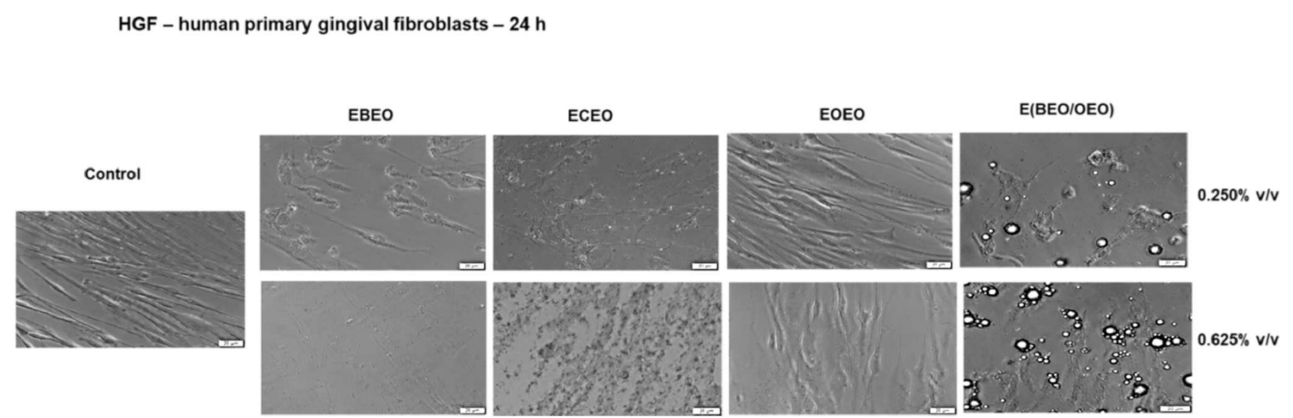
Figure 4. The morphological aspect of HGF in culture: Control unstimulated cells and cells stimulated with different test compounds: ECEO, EBEO, EOEO, and EBEO/OEO) for 24 h. The scale bar is 20 µ